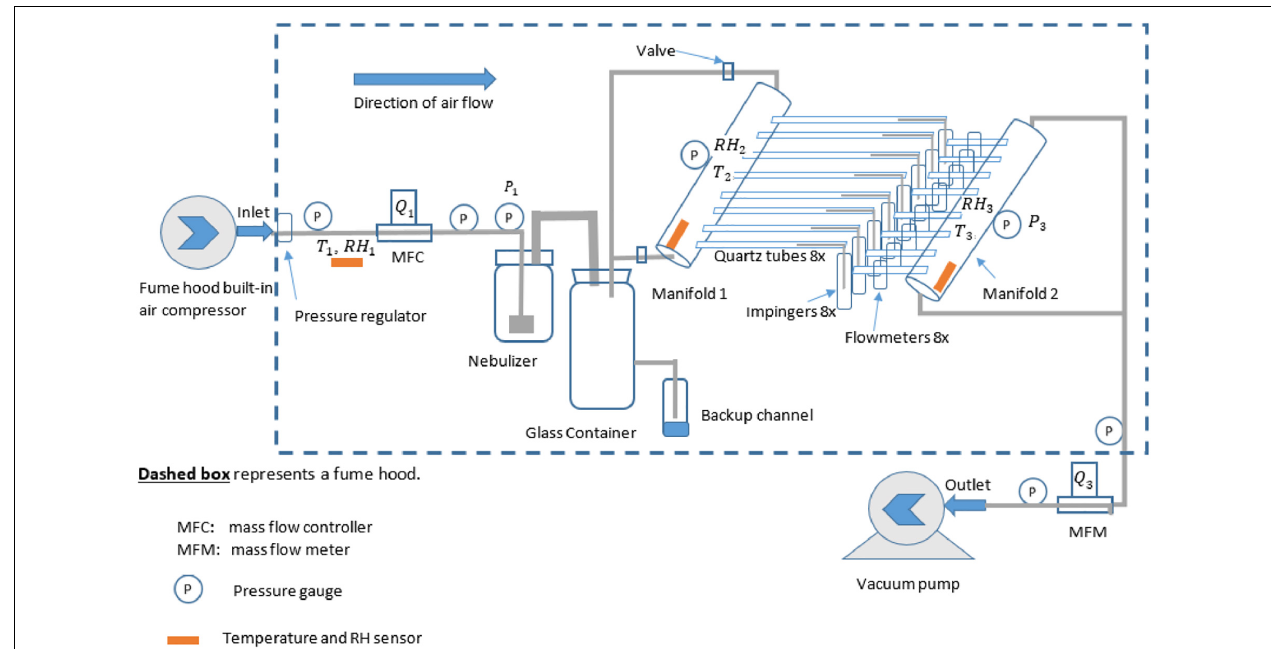
FIGURE 1 | Experimental setup for generation and collection of airborne PRRSV inside a fume hood. The built-in air compressor in the fume hood was responsible for pressurizing air flowing into the system, and the right-side pump was vacuuming exhaust air coming out of the system. MFC, mass flow controller; MFM, mass flow